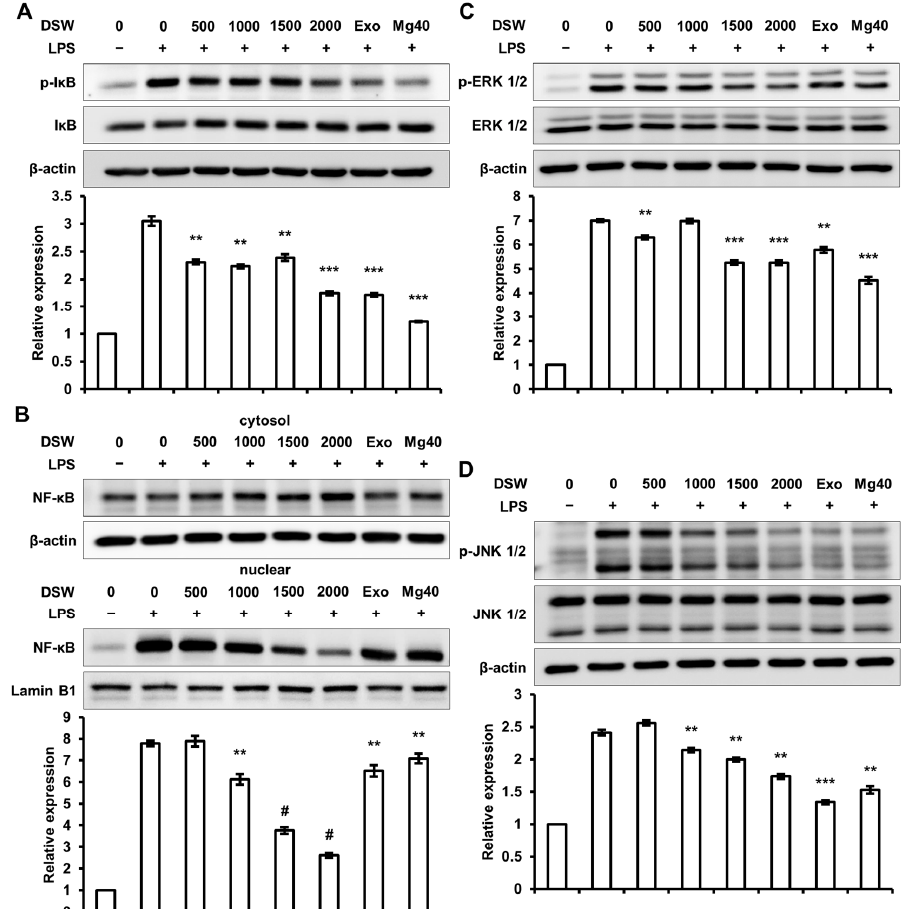
Figure 5. Effect of RDSW on phosphorylation of I κ B, nuclear translocation of NF- κ B, and activations of ERK 1/2 and JNK 1/2 in LPS-induced RAW 264.7 macrophage cells. The cells were pre-treated